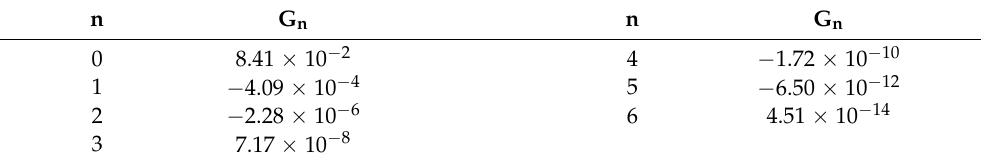
Table A11. Coefficients of the H 2 O-LiBr + LiNO 3 enthalpy equation.